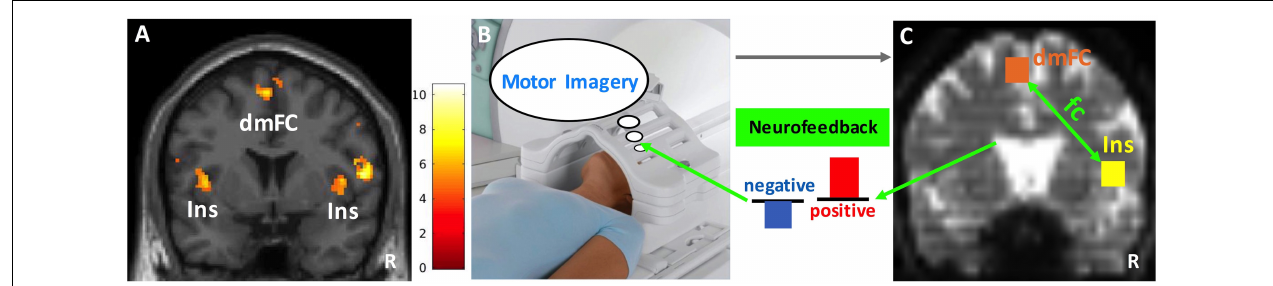
FIGURE 3 | Neurofeedback paradigm. (A) The insula (Ins) and dorsomedial frontal cortex (dmFC) group activations ( N = 10) during the heartbeat counting task are shown on a coronal slice of the canonical MNI brain template. Color bar represents the t -values. (B) Functional scans during motor imagery (40 s) were collected and preprocessed in real-time. (C) Cubic anatomical masks (6 mm × 6 mm × 6 mm) were centered at the voxel peak activity in the right insula and dorsomedial frontal cortex. These masks were created in the standard MNI space and then translated into each subject’s functional space. The signal time courses averaged across voxels within each mask were correlated with each other to compute the functional connectivity (fc) between right insula and dorsomedial frontal cortex. Finally, the z-transformed correlation values were plotted as bars to provide the neurofeedback (blue: negative, red: positive). The size of the bars reflects the magnitude of neurofeedback. R, right. Image in (B) depicts a Siemens Tx/Rx CP head coil